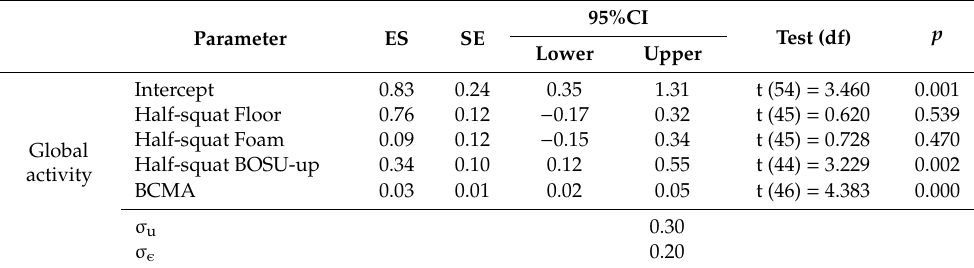
Table 2. Linear mixed model with exercise condition and BCMA as the fixed e ff ects and global activity as the dependent